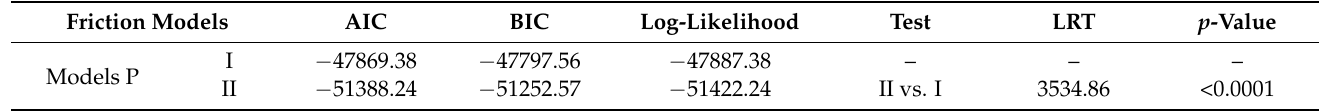
Table 10. Models P comparison.